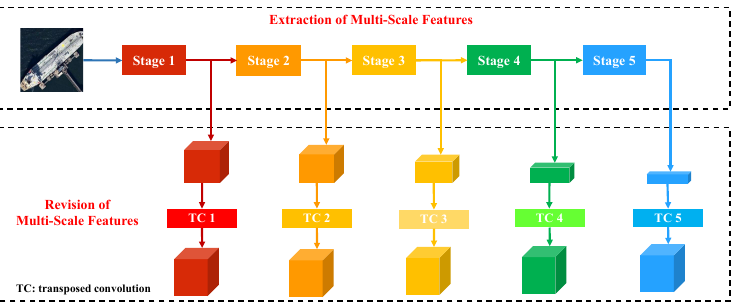
Figure 3. The structure of the extraction of multi-scale